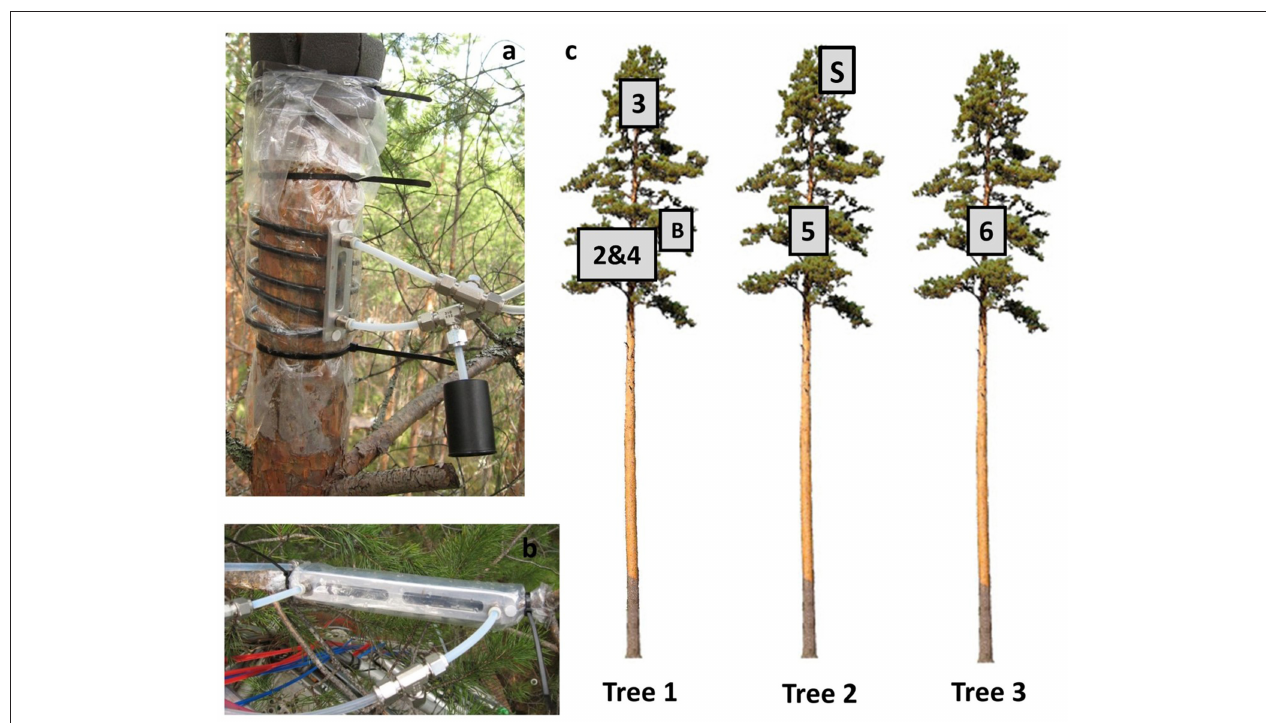
FIGURE 1 | Stem enclosure 2 (a) and branch enclosure (b) on tree #1. Supply air enters the stem enclosure via the lower tube fitting, and sample air exits via the upper one. The overflow due to slight overpressure of the enclosure exits via a T-piece of the sample tube. (c) Shows the approximate positions of the enclosures on sampled trees. The numbers refer to those introduced in Table 1 , B refers to the branch enclosure and S to the shoot enclosure.